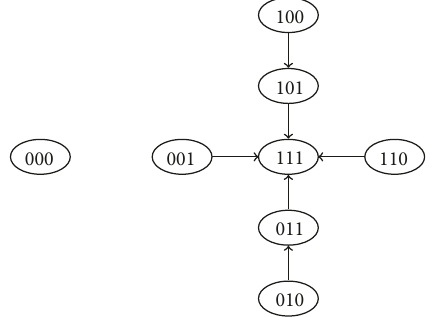
Figure 3: Phase diagram of the